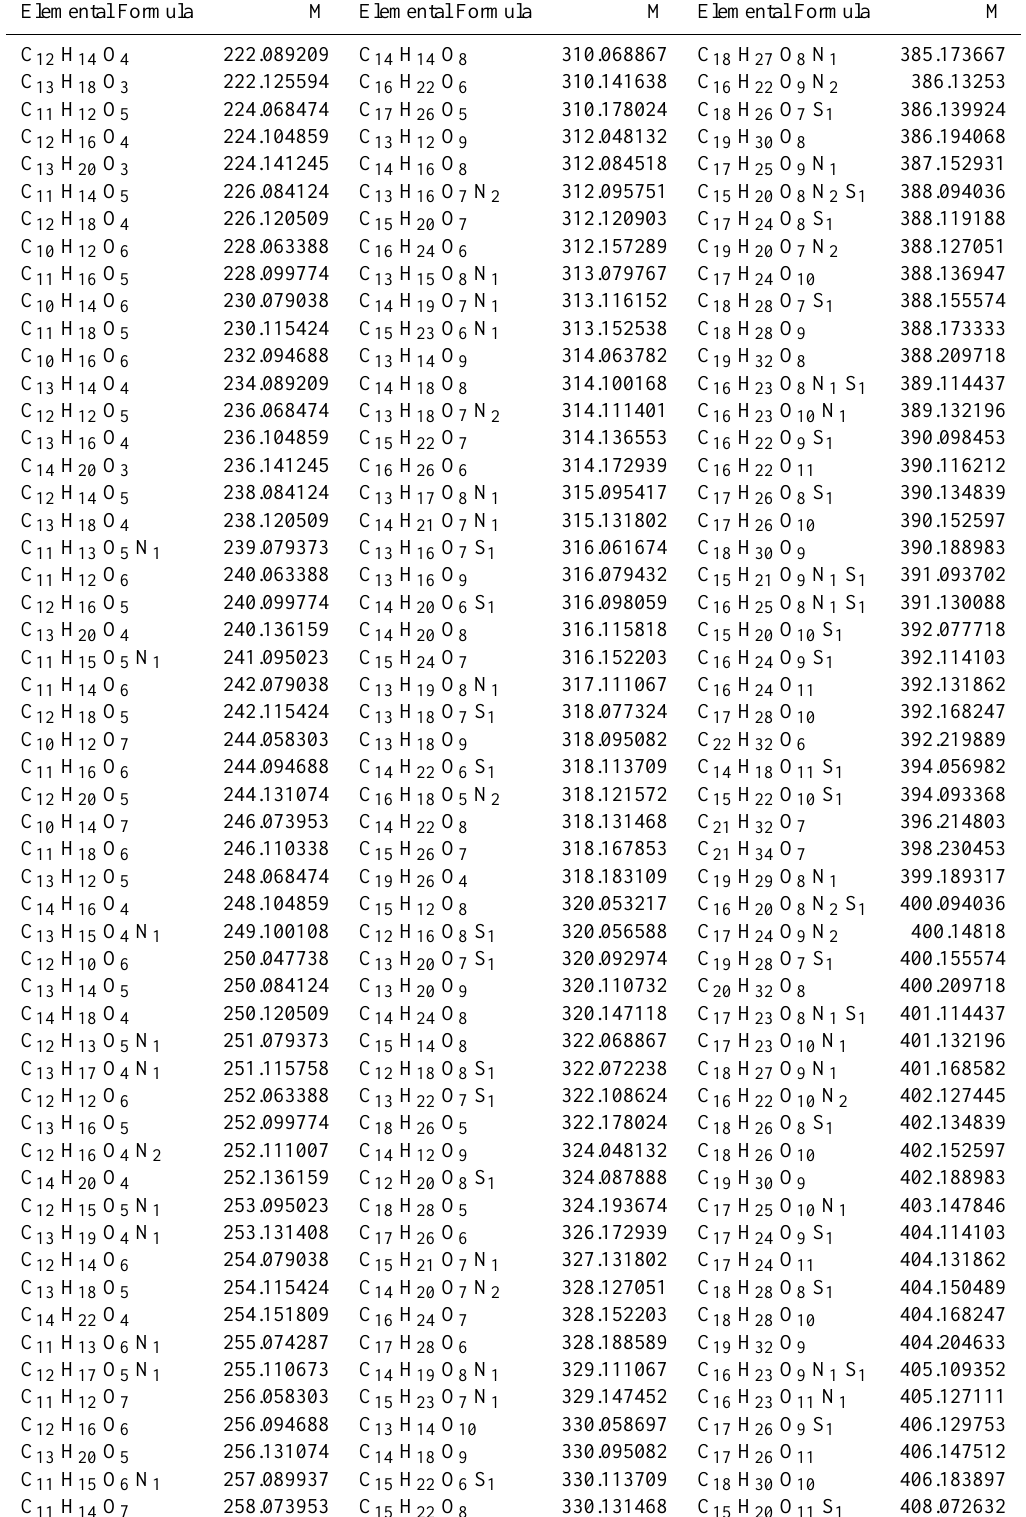
Table A1. POS molecular formulas: complete list of mass peaks and assigned molecular formulas that showed a highly significant positive correlation ( p < 0 . 01) with SPE-DOM 1 14